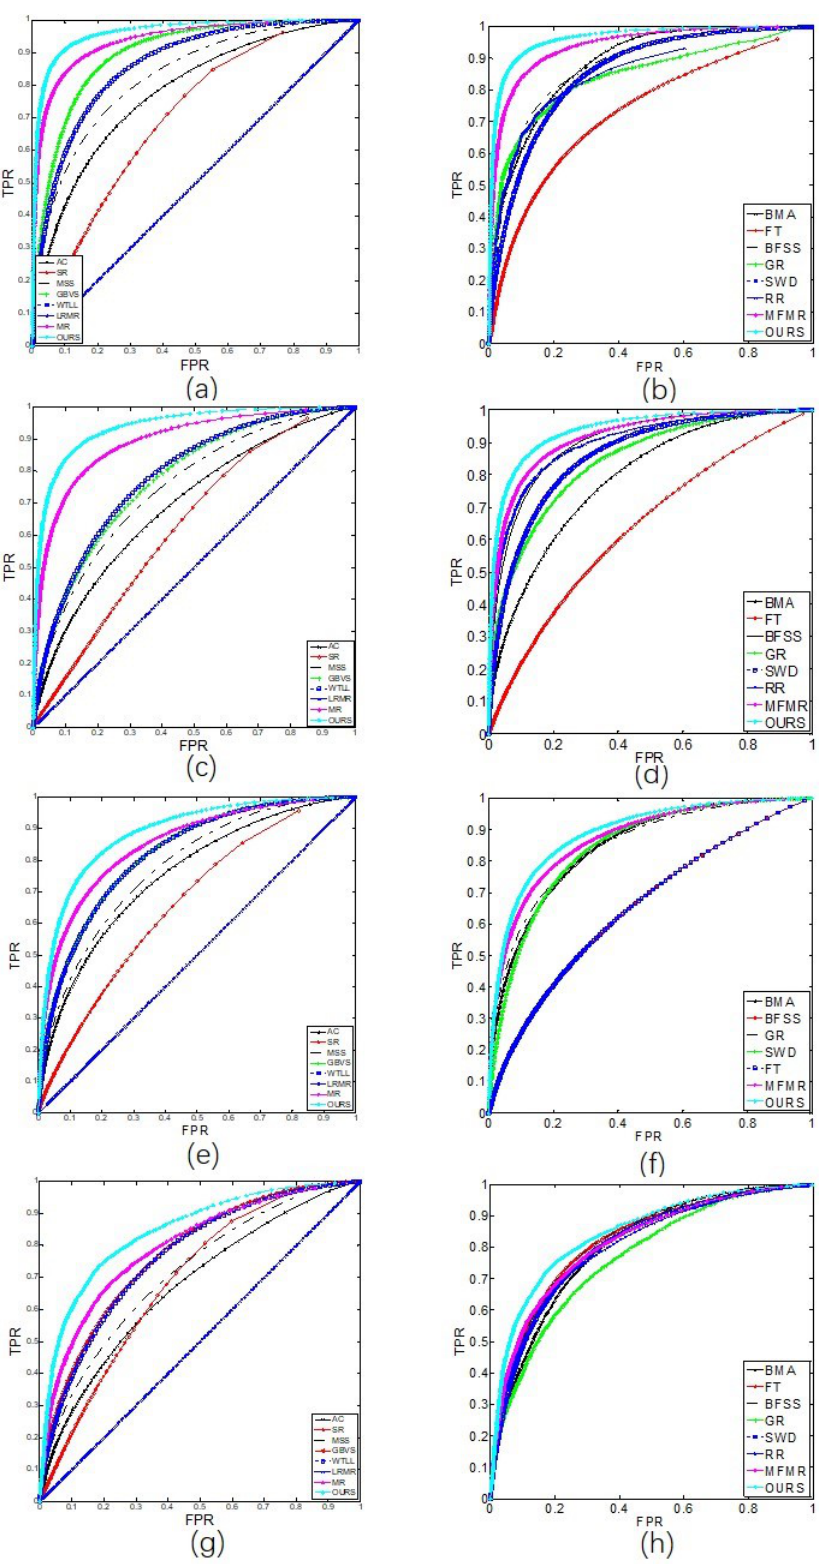
Figure 6. The ROC curves of different methods on four datasets: ( a , b ) MSRA-5000 dataset; ( c , d ) ECSSD dataset; ( e , f ) DUT-OMRON dataset; ( g , h ) SOD